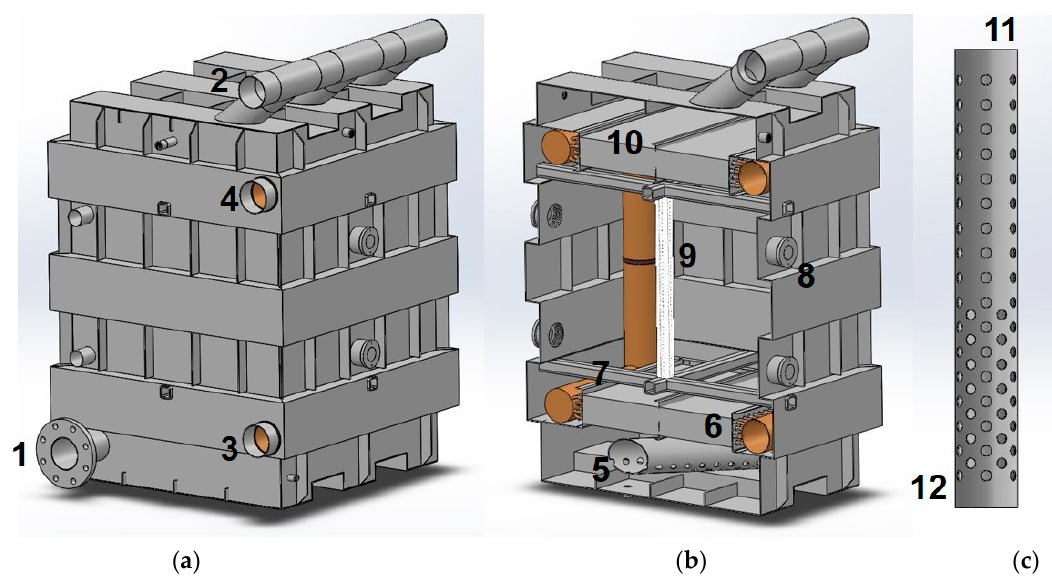
Figure 4. Bubble reactor prototype description: ( a ) exterior; ( b ) cross section; ( c ) holed duct. (1) air inlet, (2) air outlet, (3) heat exchanger inlet, (4) heat exchanger outlet, (5) holed duct, (6) first heat exchanger, (7) reinforcing crosses, (8) visual access, (9) measurement rule, (10) second heat exchanger, (11) beginning of the holed duct and (12) end of the holed duct.